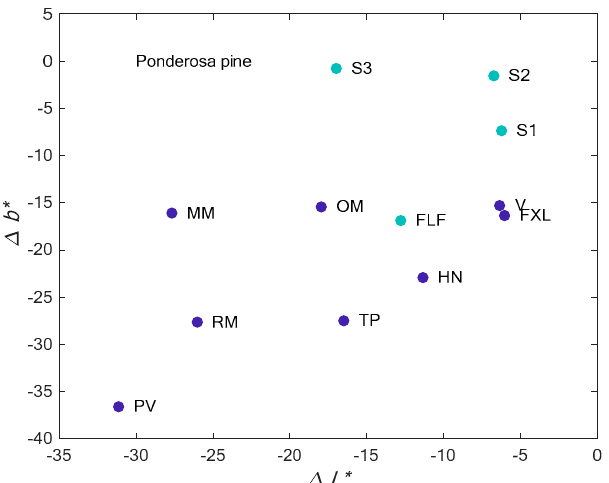
Figure 20. Cluster results according to linkage distances calculated with MANOVA using 18-month ∆ L *, ∆ a *, and ∆ b * values.